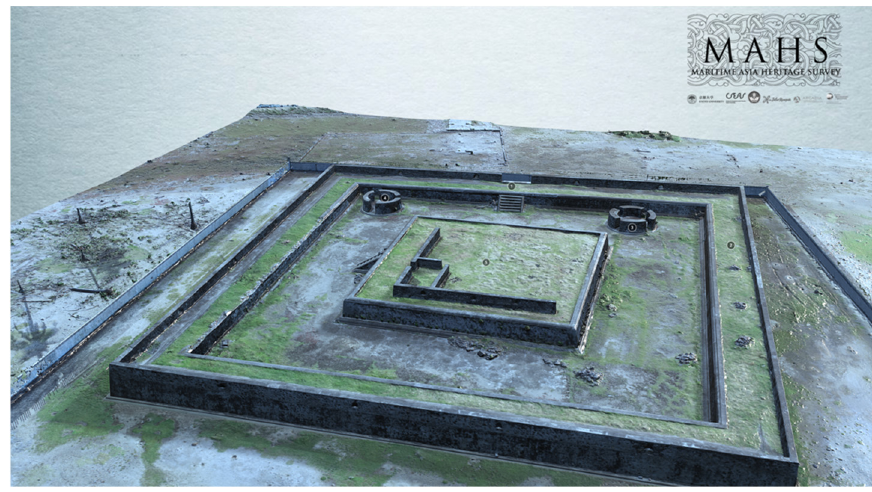
Figure 3. 3-d visualization of Benteng Indrapatra, a fort complex built during the 16th or 17th century CE along the coast of Aceh, Indonesia. The image was produced using drone photogrammetry.